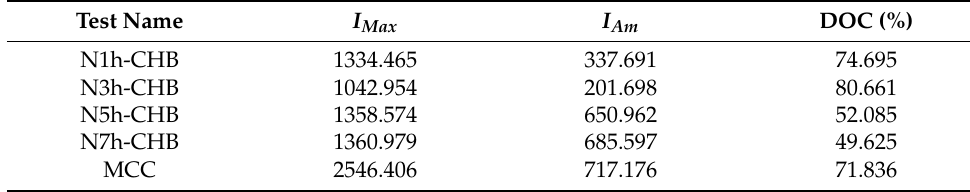
Table 3. The crystallinity of four cellulose samples and